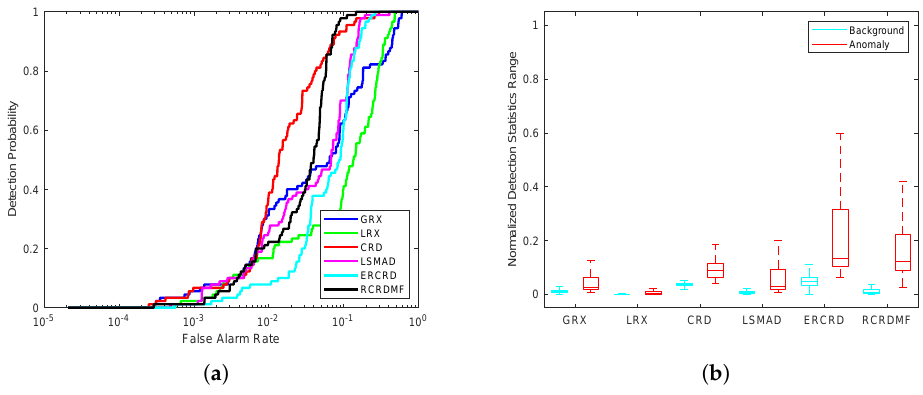
Figure 10. Detection accuracy evaluation for the AVIRIS-III dataset. ( a ) ROC curves. ( b ) Normalized background-anomaly separation